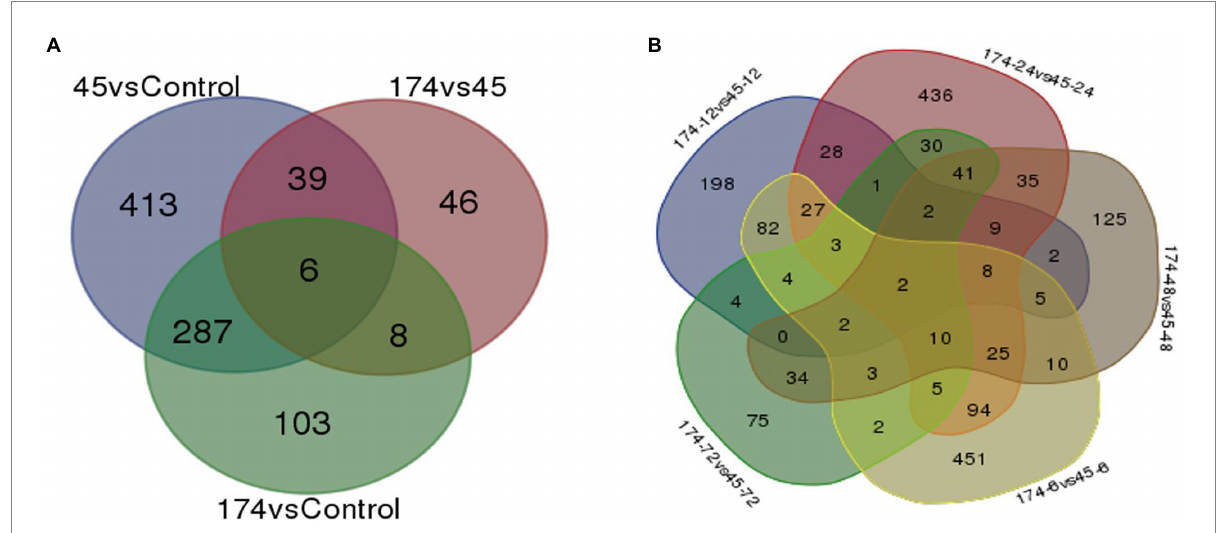
FIGURE 1 Uniquely and commonly expressed genes in pearl millet inbred ICMB 93333 during M. grisea infection by incompatible (Pg 45) and compatible (Pg 174) isolates (A) at all time periods and (B) at specific